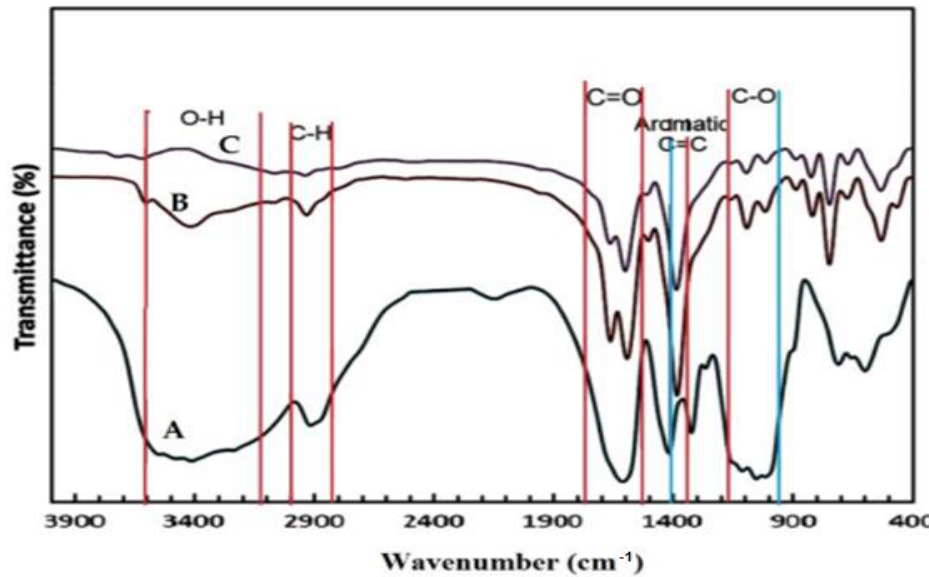
Figure 1. FT-IR spectra of ( A ) CMC; ( B ) Zn@BTC and ( C ) CMC/Zn@BTC.